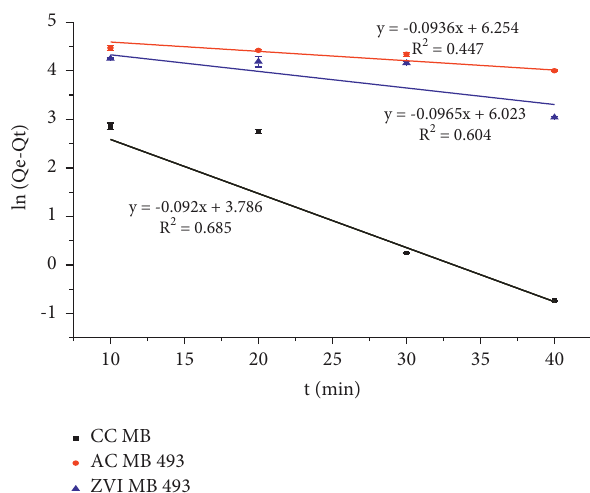
Figure 12: Adsorption curves of the pseudo-first-order model onto CC MB, AC MB 493, and ZVI MB 493 at 95 °